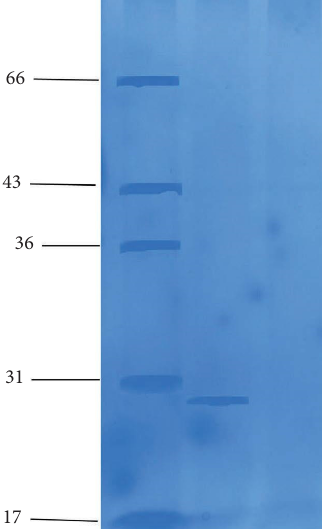
Figure 6: SDS-PAGE of purifed protein (17–66 kDa). Lane1, protein standard marker. Lane 2, purifed antilarval protein.